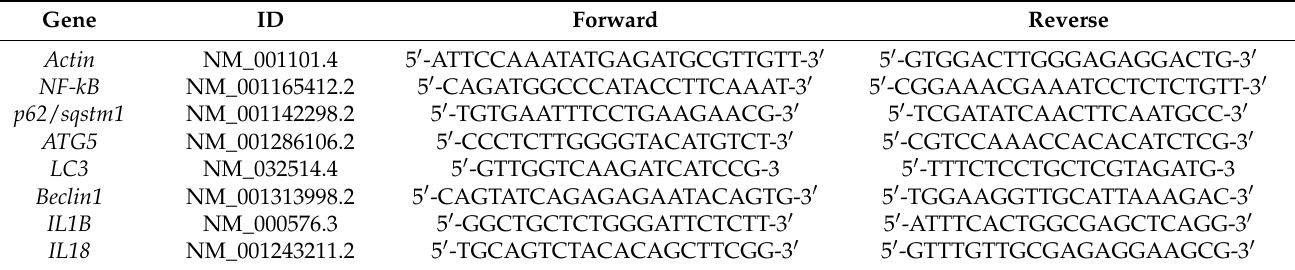
Table 3. Primers used for